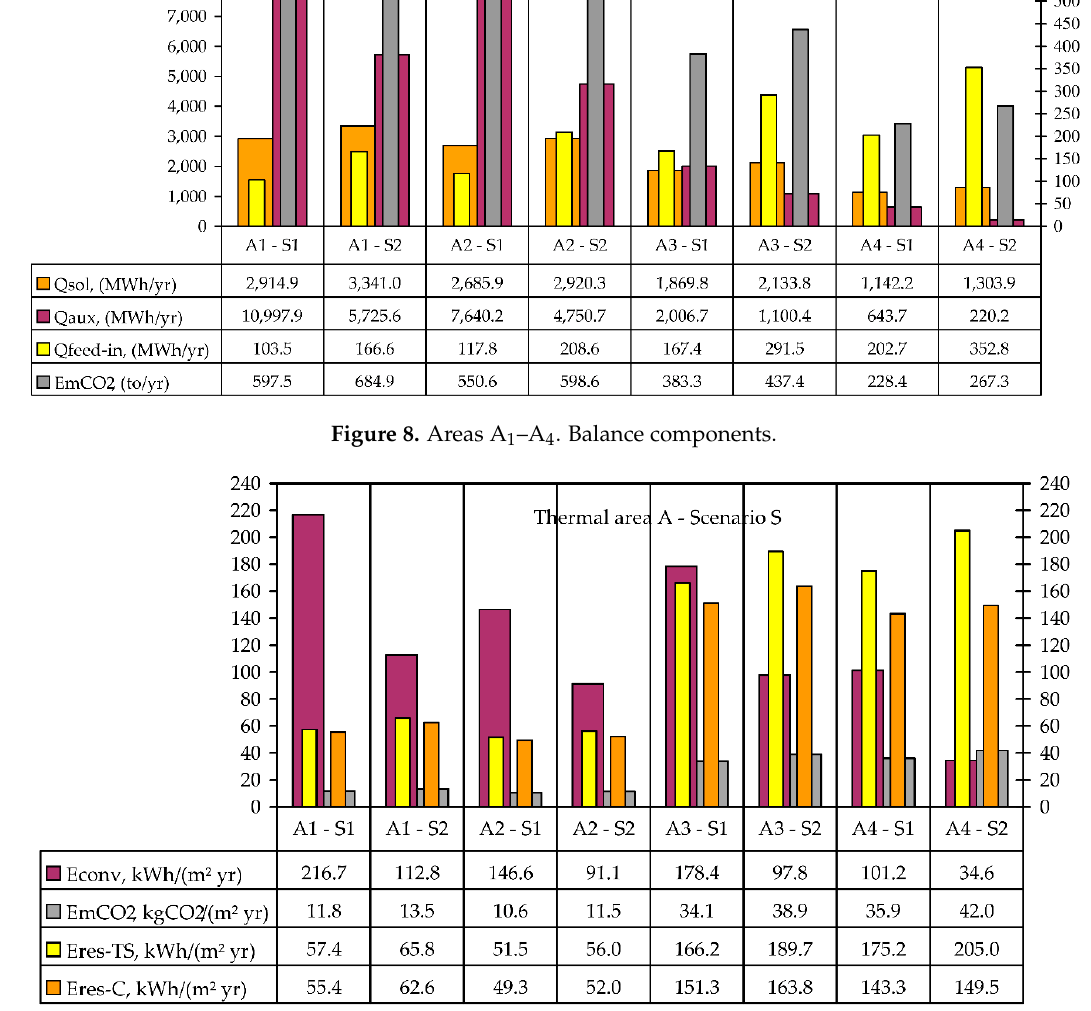
Figure 9. Energy performance indicators. Areas A 1 –A 4 .